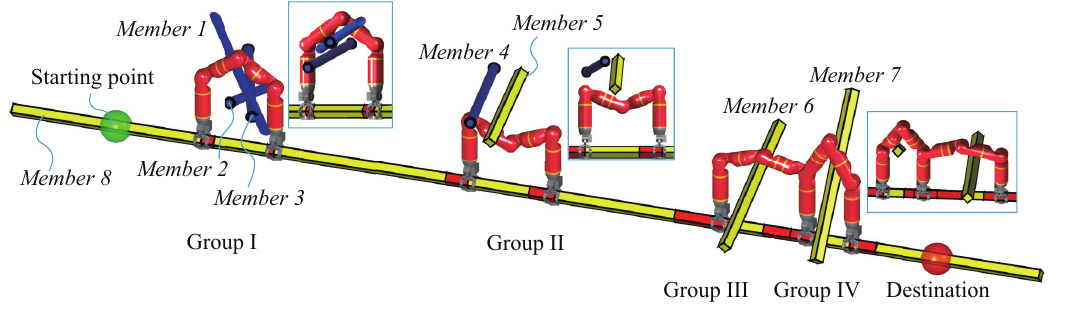
Figure 11. The results of computing operational regions for negotiating multiple